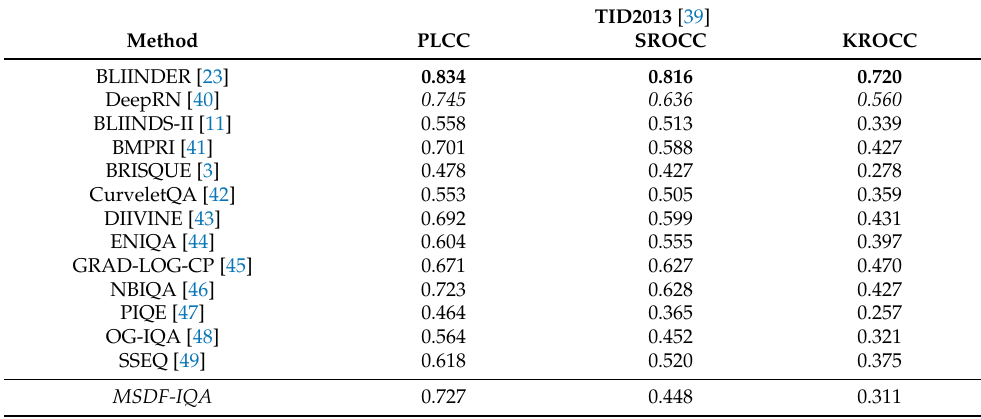
Table 9. Comparison of MSDF-IQA to the state-of-the-art on artificial distortions (TID2013 [39]). Median PLCC, SROCC, and KROCC values were measured over 100 random train–test splits. Best results are typed in bold, and second best results are typed in italic.